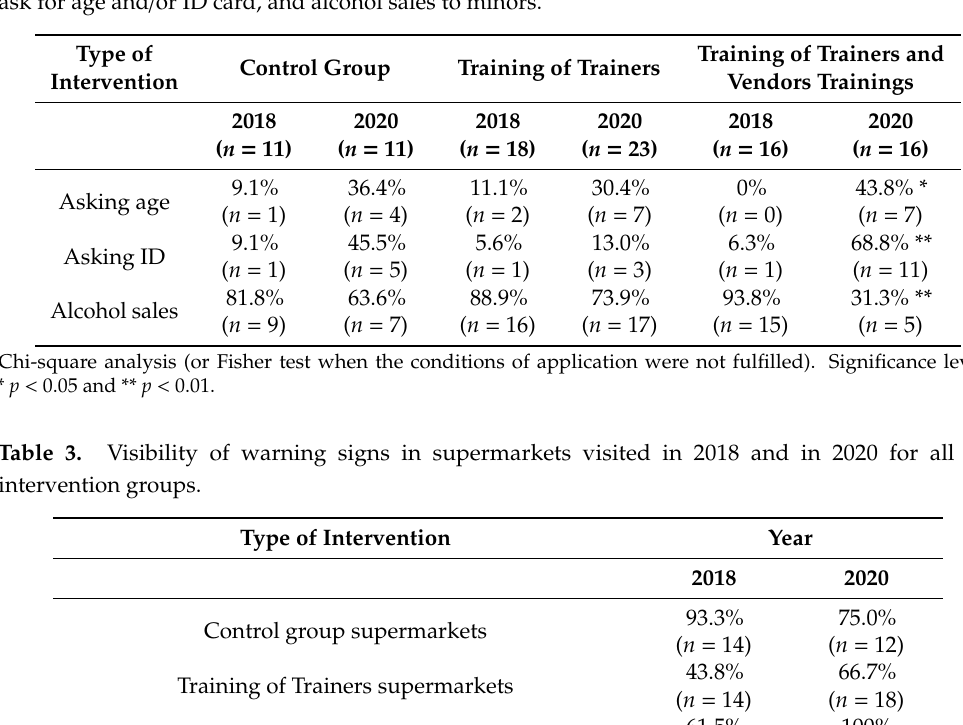
Table 2. Frequency of vendors’ compliance with age limitations for alcohol sales in supermarkets with older minors (16–17 years old). Compliance was assessed through three indicators: whether cashiers ask for age and / or ID card, and alcohol sales to minors.